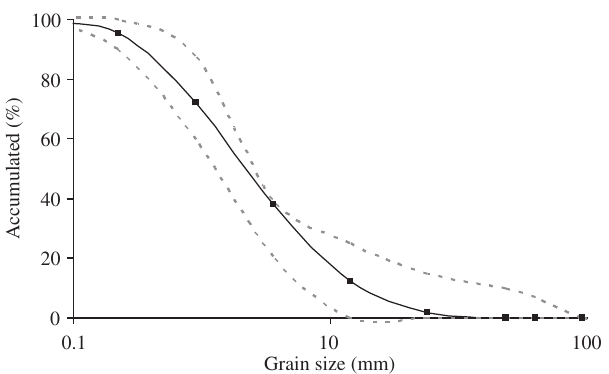
Figure 4. Model of “capillary water absorption (kg.m –2 ) x square root of time (min 1/2 )” up to the point of saturation, according to the NBR 9779 standard for the determination of capillary absorption coefficients (tan j